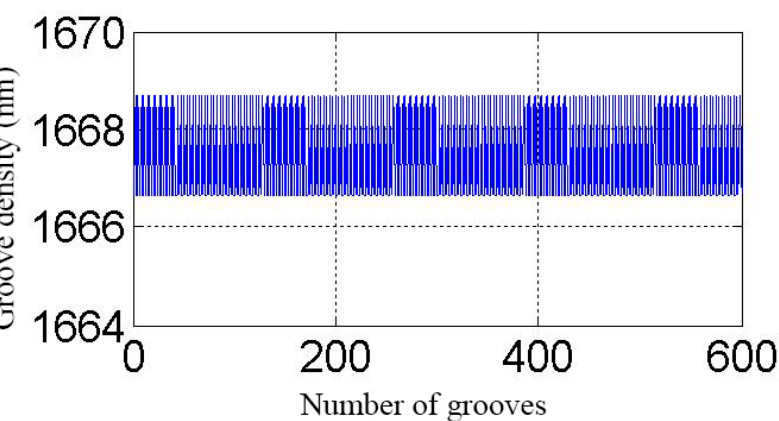
Figure 8. The distribution of grooving period error caused by the worm error with Amplitude of 2 nm and Period of 3 groove.